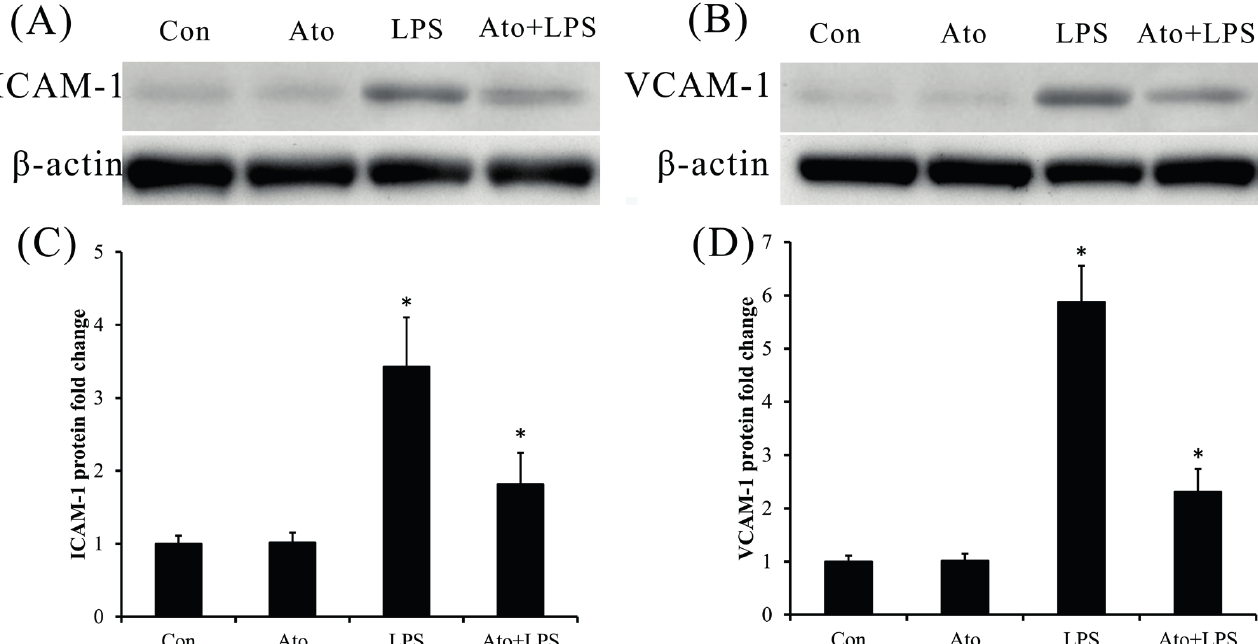
FIGURE 4 - The effects of atorvastatin on LPS-induced ICAM-1 and VCAM-1 expression in HCAECs. (A) Protein expression of ICAM-1 in HCAECs was assessed by Western blotting after treatment with LPS and atorvastatin. (B) Protein expression of VCAM-1 in HCAECs was assessed by Western blotting after treatment with LPS and atorvastatin. (C) Protein expression of ICAM-1 in HCAECs was quantified using densitometry, and normalized to β -actin. Statistical analysis was performed on Ato, LPS and Ato+ LPS versus Con group, respectively. (D) Protein expression of VCAM-1 in HCAECs was quantified using densitometry, and normalized to β -actin. Statistical analysis was performed on Ato, LPS and Ato+ LPS versus Con group, respectively.Data are expressed as mean values SE of three independent experiments. *P<0.05 indicates significant